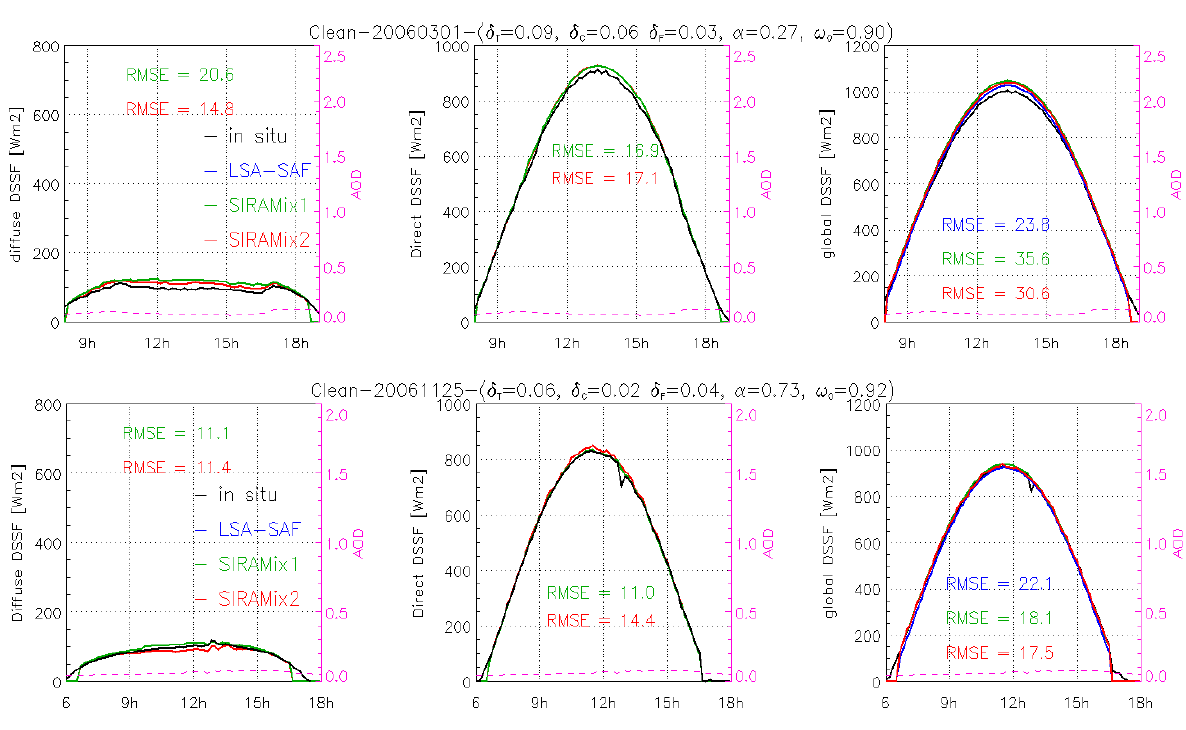
Figure 5. Diurnal cycle of diffuse, direct and global downwelling surface shortwave flux (DSSF) for clean days in (top) Dakar (1 March) and (bottom) Niamey (25 November). The black curve represents the in situ measurements, the blue is the LSA-SAF estimation, the green is the SIRAMix1 configuration simulation and the red is the simulation with the SIRAMix2 approach. The root mean square error (RMSE) between each method and the in situ measurement is displayed. Instantaneous aerosol optical depth (AOD) measured by the AERONET sun-photometer is shown in